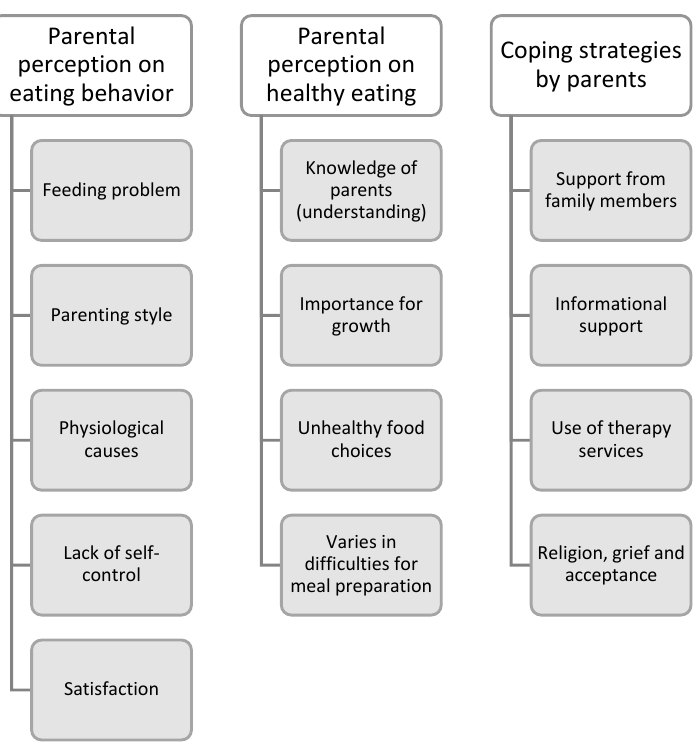
Figure 1. The summary of emerging themes.